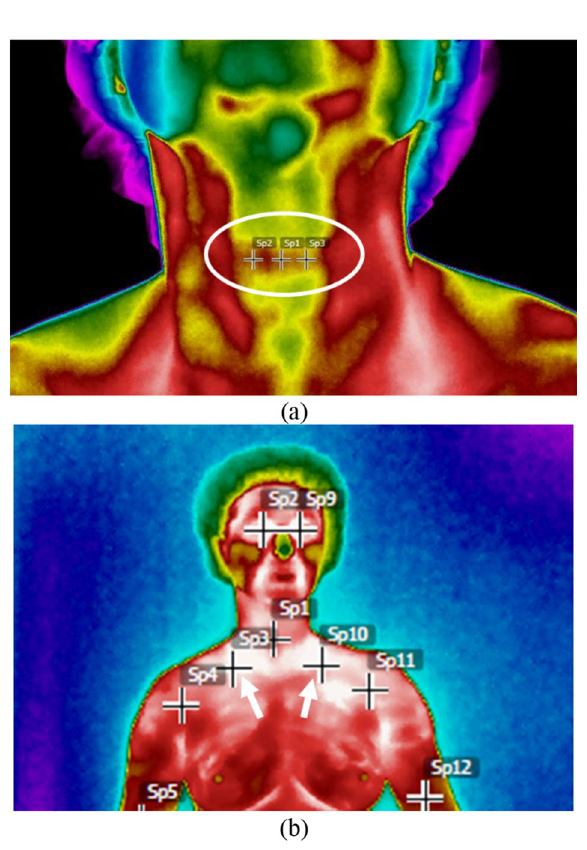
Figure 2. Points to measure the temperature in the ( a ) thyroid region and ( b ) in the brown adipose tissue (BAT) region (SP3 and